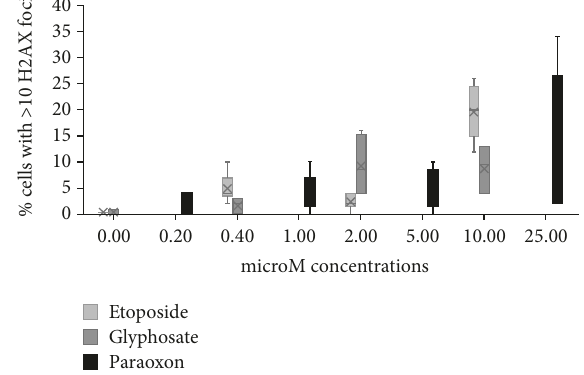
Figure 3: Percentage of cells with more than 10 gamma-H2AX foci induced by treatments with etoposide, glyphosate, and paraoxon. The three compounds induced an increase related to the dose; see Results for statistical values of linear regression